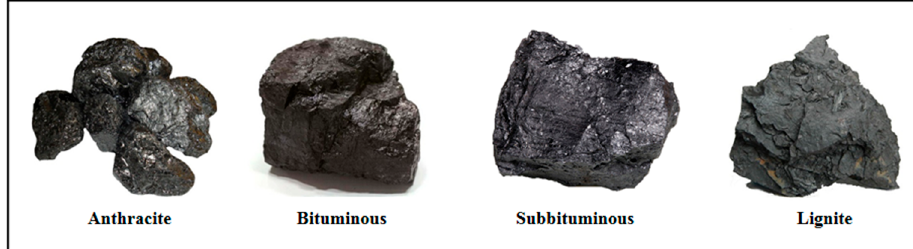
Figure 7. Different types of coal [31].